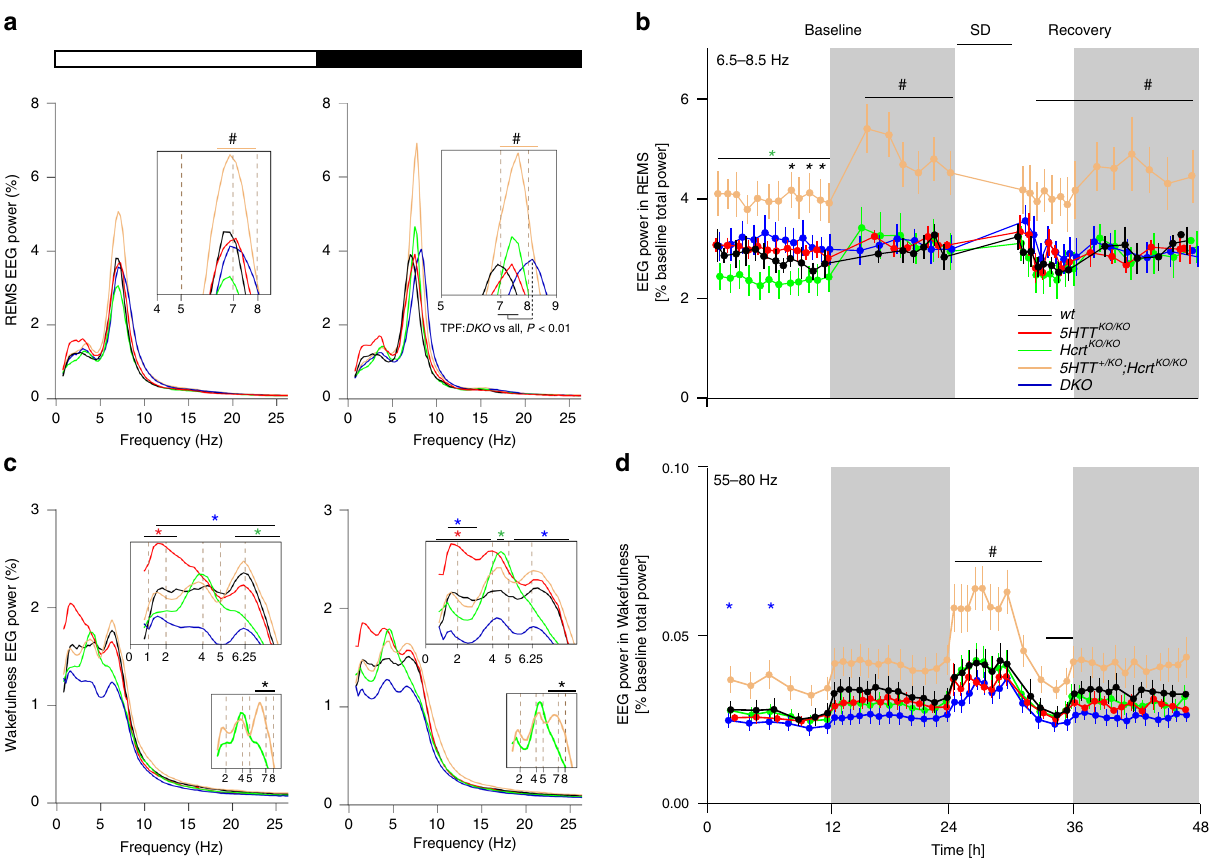
Fig. 3 REMS EEG theta power is increased in 5HTT + /KO ;Hcrt KO/KO mice. a EEG power spectra in baseline REMS during light (left) and dark (right) periods. (two-way ANOVA, interaction frequency × genotype F (388, 2037) = 3.34 (light) and 6.35 (dark), P < 0.0001, followed by Dunnett ’ s test, 5HTT + /KO ;Hcrt KO/KO vs all # P < 0.05) . Insets show higher resolution. REMS theta peak frequency (TPF) is faster in DKO mice compared to all other genotypes. b REMS theta (6.5 – 8.5 Hz) power dynamics in the course of the 3-day recording. Powers within this frequency range are higher during the dark period (baseline one and two are averaged) (two-way ANOVA, interaction time × genotype F (124, 651) = 2.97, P < 0.0001, followed by Dunnett ’ s test, 5HTT + /KO ;Hcrt KO/KO vs WT *, DKO *, 5HTT KO/KO *, Hcrt KO/KO *, all P < 0.05). c Waking baseline EEG power spectra for all genotypes during baseline light (left) and dark (right) periods. The values are expressed as the percentage of each mouse ’ s total baseline EEG power. Insets show higher resolution. Smaller insets represent differential expression of waking theta power in cataplexy-exhibiting mice (two-way ANOVA, interaction frequency × genotype F (388, 2037) = 3.04 (light) and 2.28 (dark), P < 0.0001, followed by Dunnett ’ s test, WT vs 5HTT + /KO ;Hcrt KO/KO *, DKO *, 5HTT KO/KO *, Hcrt KO/KO * and # P < 0.05, insets 5HTT + /KO ;Hcrt KO/KO vs Hcrt KO/KO * P < 0.05). d Waking EEG fast-gamma (55 – 80 Hz) power dynamics in the course of the 3-day recording (baseline one and two are averaged) (two-way ANOVA, interaction time × genotype F (164, 861) = 3.8, P < 0.0001, followed by Dunnett ’ s test, 5HTT + /KO ;Hcrt KO/KO vs WT *, DKO *, 5HTT KO/KO *, Hcrt KO/KO * P < 0.05; ** P < 0.01; *** P < 0.001). # in ( a , b ) and ( d ) P < 0.05, 5HTT + /KO ;Hcrt KO/KO vs all other genotypes. Values are mean ± SD. DKO : n = 7, 5HTT KO/KO : n = 4, Hcrt KO/KO : n = 5, 5HTT + /KO ;Hcrt KO/KO : n = 6 and WT : n =